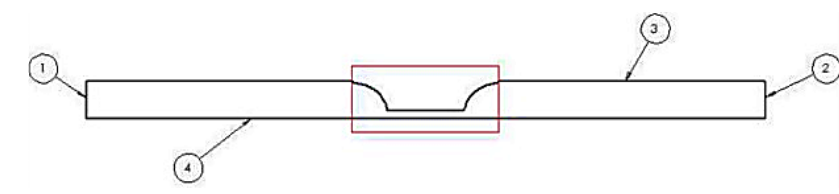
Figure 3. 2D flow axis-symmetric flow domain for the present case: The numbers represent boundaries of flow domains, ( 1 ) inlet, ( 2 ) outlet, ( 3 ) wall, ( 4 ) axis.